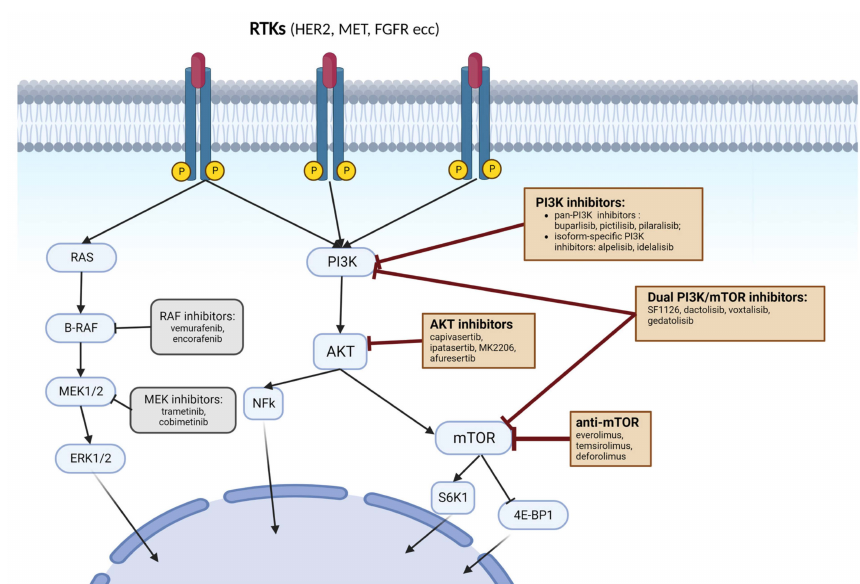
Figure 2. Summary of the complex phosphatidylinositol-3-kinase (PI3K)/AKT/mTOR signalling pathway and